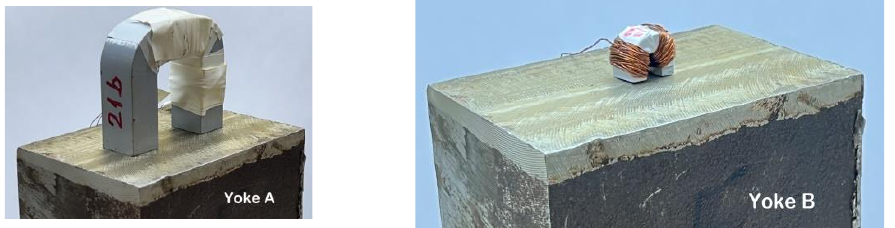
Figure 4. Photographs of two different size magnetizing yokes ( Yoke A and Yoke B ) on the top of the same block.